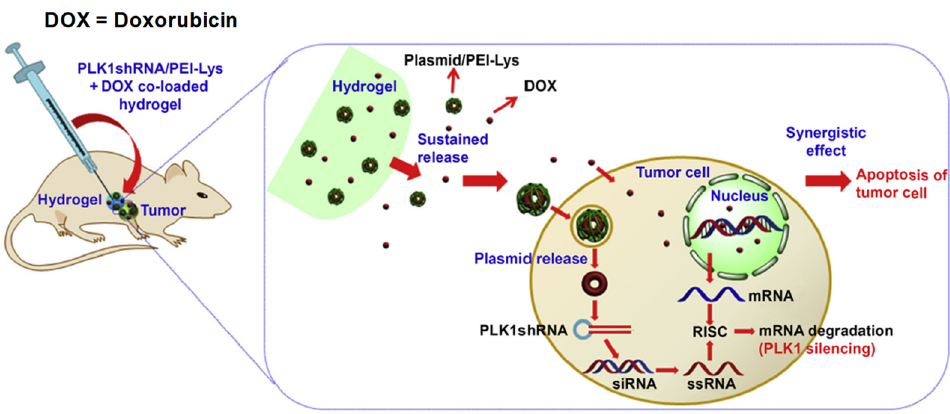
Figure 18. Schematic illustration for the synergistic effect of PLK1shRNA/PEI-Lys and DOX co- loaded hydrogel on a tumor in nude mice. Reprinted with permission from ref. [58]. Copyright © 2014 from Biomaterial , Elsevier.